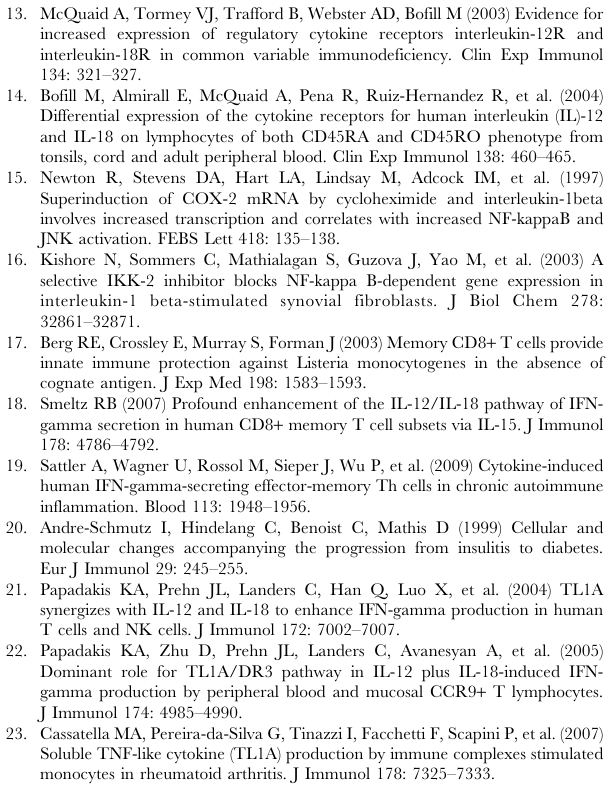
(TIF) Figure S3 Freshly isolated human peripheral blood CD4 + T cells from two independent donors were stimulated with IL-12 (1 ng/ml)/IL-18 (40 ng/ml) for various periods of times to measure IFN- c production. (TIF) Figure S4 Freshly isolated human peripheral blood CD4 + T cells from two independent donors were cultured either in the medium alone or in the presence of IL-12 plus IL-18 for various periods of times. At each time point, cell viability was determined by trypan blue staining, and cell numbers were determined by cell count.